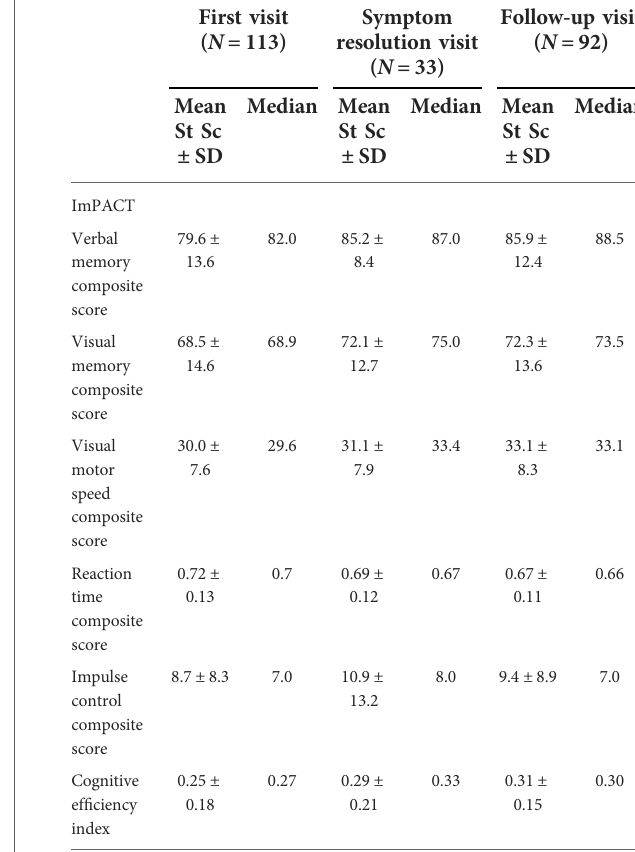
TABLE 5 ImPACT scores for youth with concussion ( N